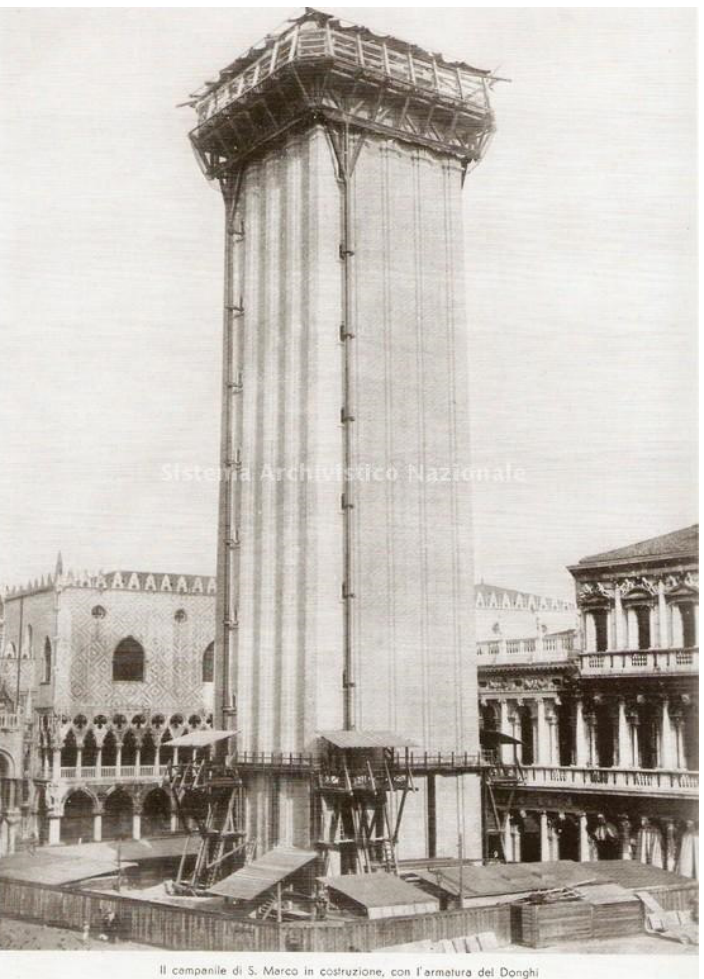
Figure 1. Reconstruction of the San Marco bell tower, Venice (http://san.beniculturali.it/web/san/dettaglio-oggetto-digitale?pid=san.dl.SAN:IMG-00429727, Sistema Archivistico Nazionale, December, 2022).